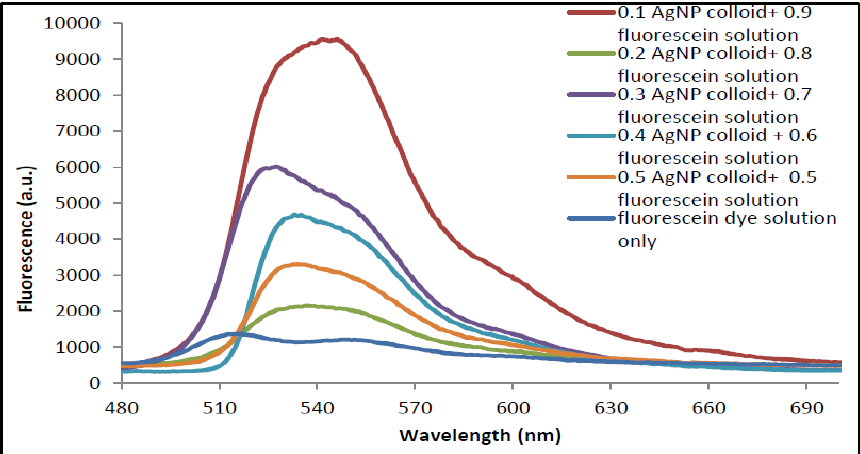
Figure 10: Total fluorescence of Ag NPs and fluoreseina dye mixture solution with different mixing ratio.